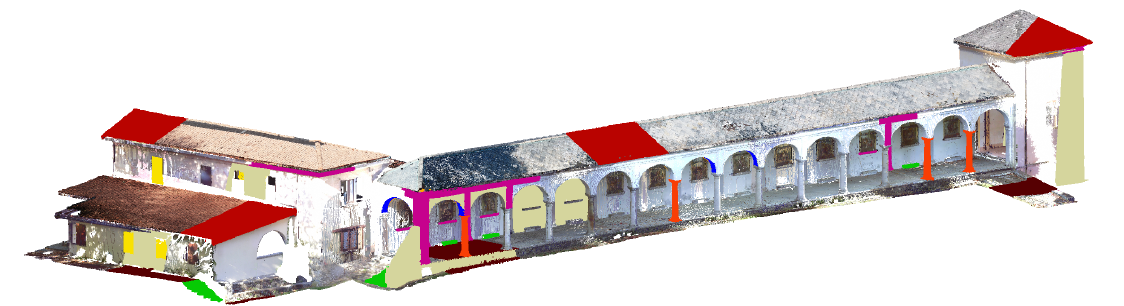
Figure 7. Manual annotations used to train the ML algortihms for the Sacred Mount of Ghiffa (SMG) Scene.